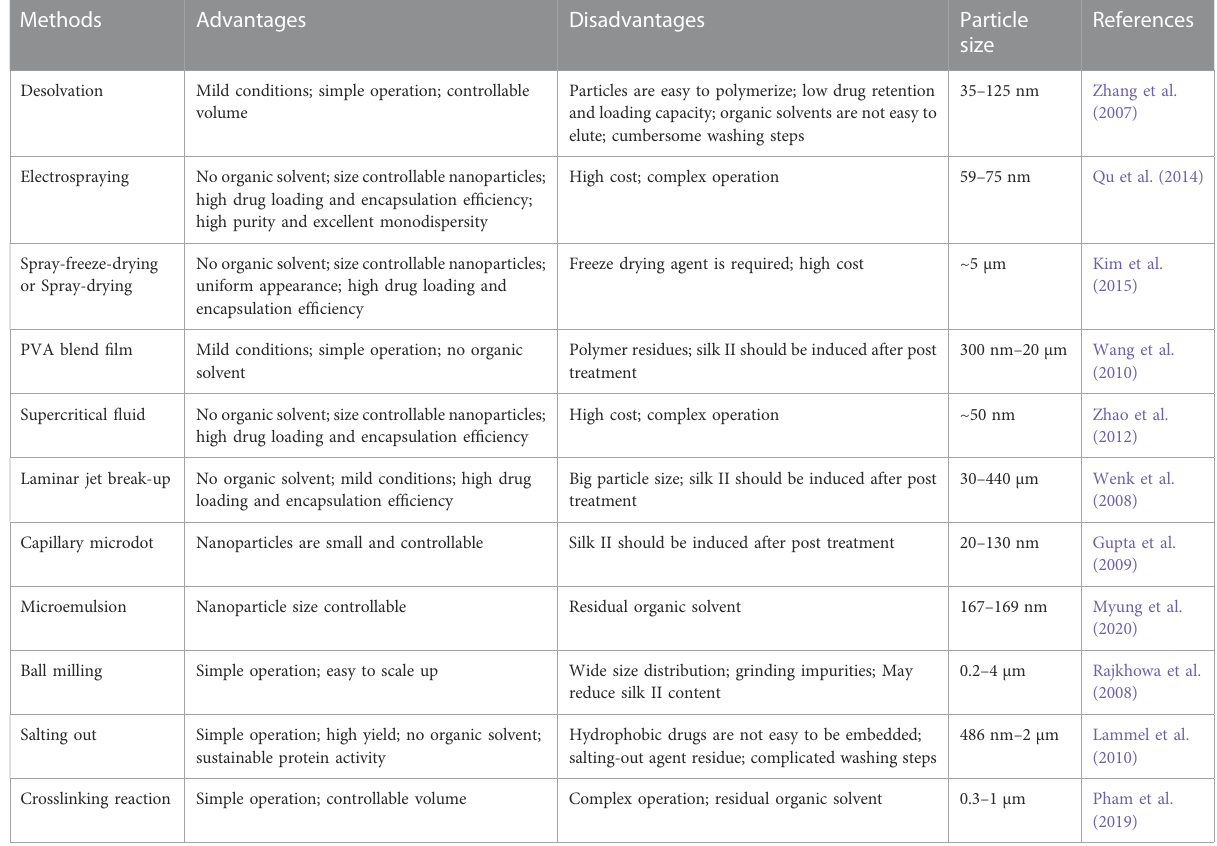
TABLE 3 Common preparation methods for nanoparticles of silk fi